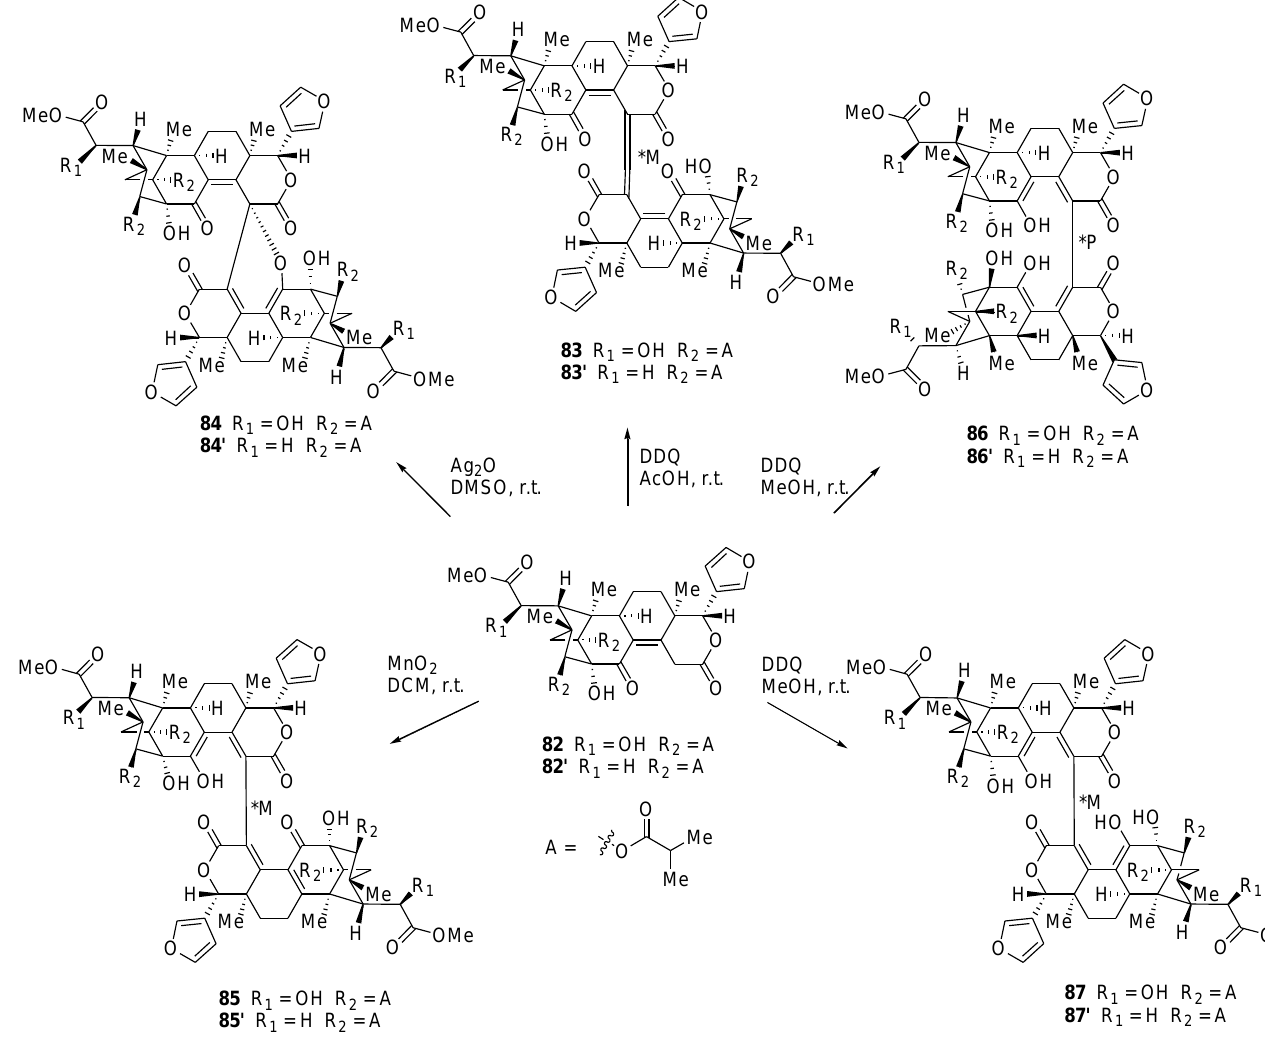
Figure 17. Formation of the limonoid dimers 83 , 83 ’ , 84 , 84 ’ , 85 , 85 ’ , 86 , 86 ’ , 87 , and 87 ’ along with their corresponding starting compounds 6 R -hydroxymoluccensin A ( 82 ) and moluccensin A ( 82 ’ ).